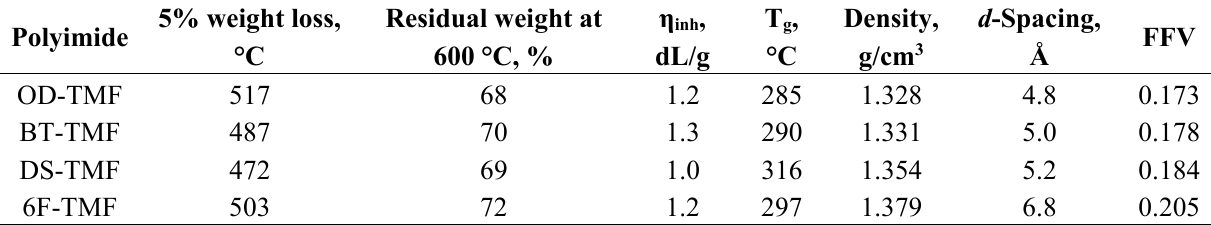
Table 2. Some important physical properties determined for the TMF-based polyimides synthesized in this work.